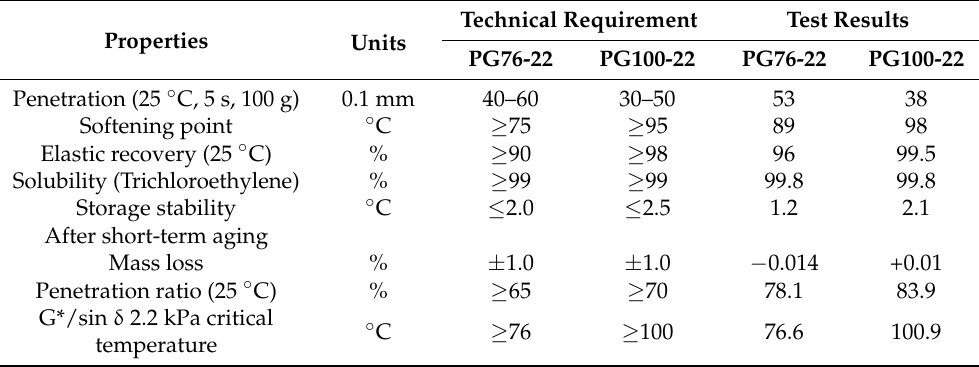
Table 1. Properties of the SBS modified asphalt (PG76-22) and high-viscosity and high-elasticity modified asphalt